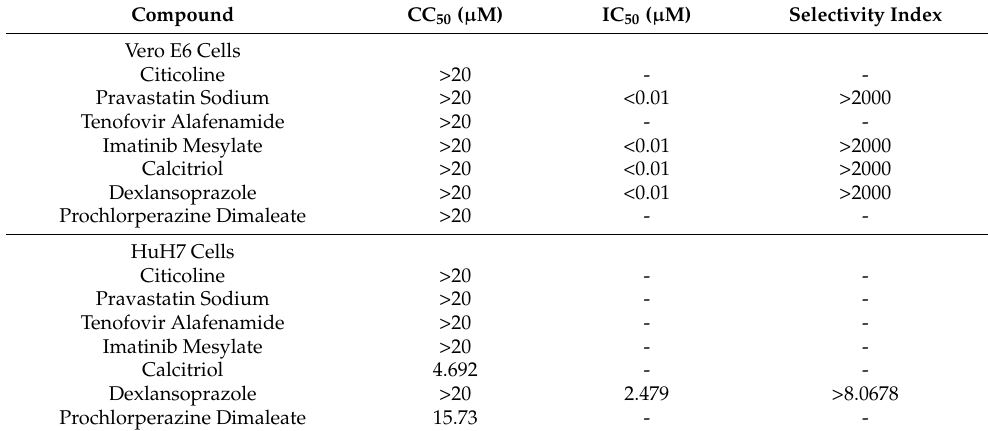
Table 3. CC 50 , IC 50 , and SI values observed from validation of primary hits in Vero E6 and Huh7 cells.